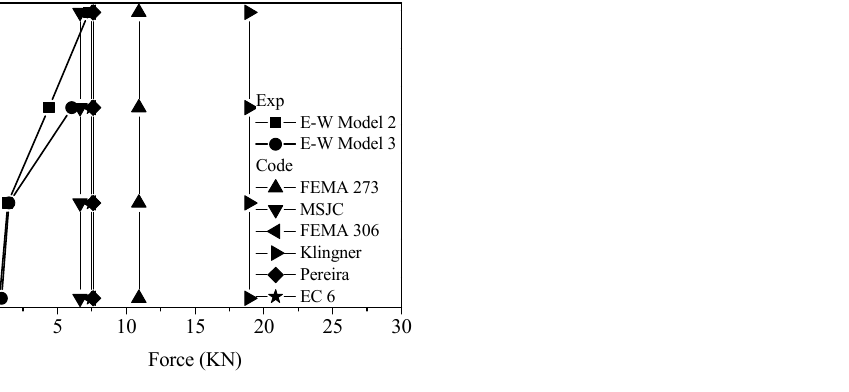
Figure 16. Standard and experimental out-of-plane capacity comparison for transversal infill walls of models 2 and 3 after the reduction of analytical values using [7].